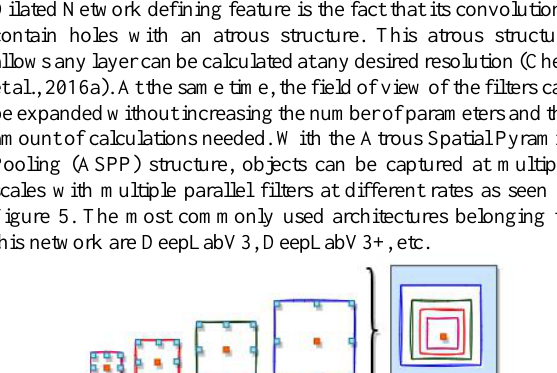
Figure 2 . CSCRS Istanbul Building Dataset content includes different types.